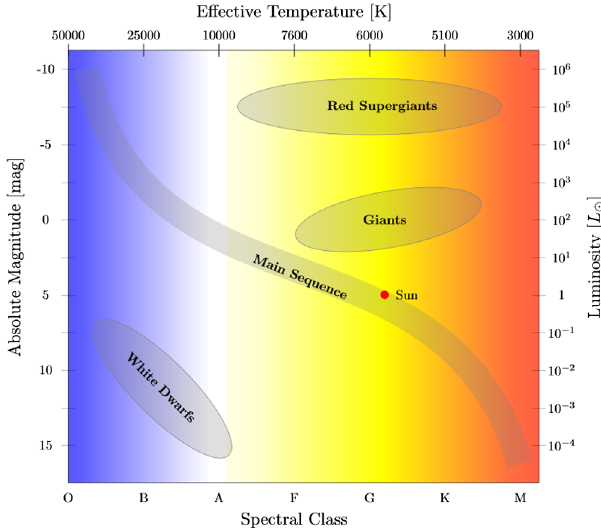
FIG. 1. A typical Hertzsprung-Russell diagram that contains information about central stellar properties. The spectral class and effective temperature (in kelvins) are shown in the horizontal direction, and the absolute magnitude (in mag) and the luminosity (in solar luminosity) are shown in the vertical direction. The colored background represents the color of the star. This example contains the Sun and four luminosity classes that are part of the stages of stellar evolution (see text for